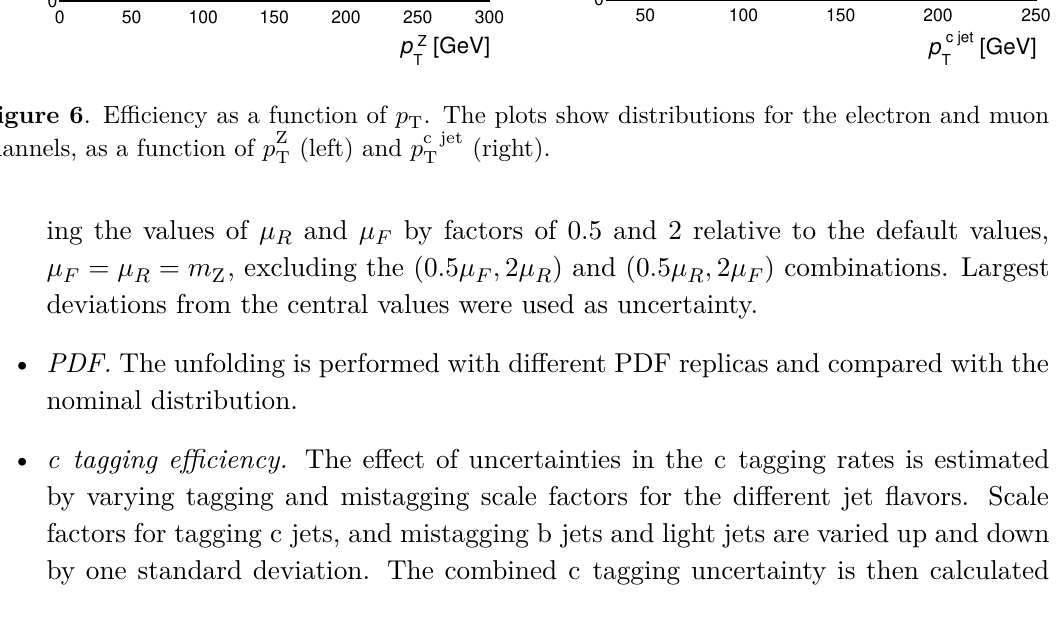
Figure 6 . Efficiency as a function of p channels, as a function of p Z